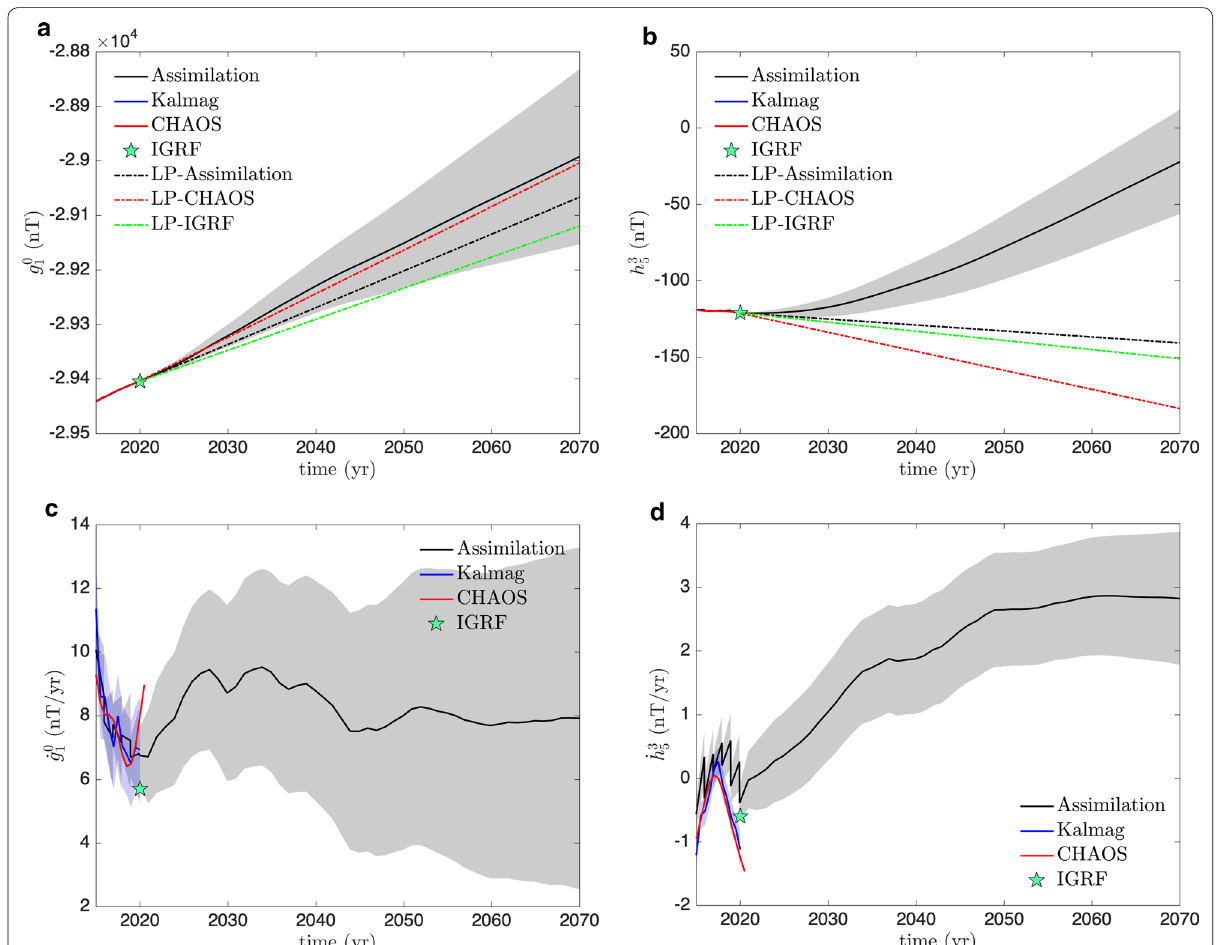
Fig. 9 Same as Fig. 4, but for predictions of the axial dipole g 0 1 and h 3 5 coefficients and their SV after the assimilation of COV-OBS and Kalmag until the year 2020. The green star now shows the